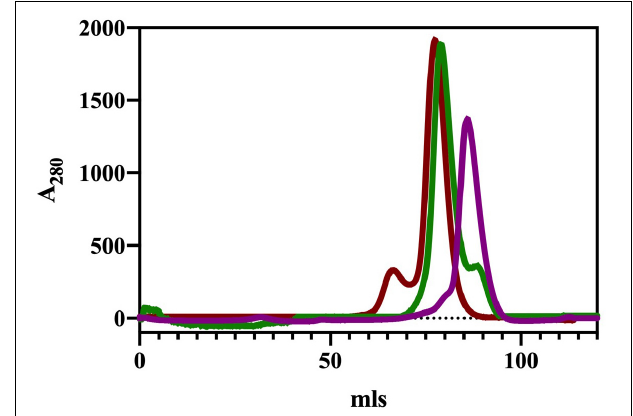
FIGURE 1 | Gel filtration chromatography elution (Superdex 200) of ChTK-C, ChTK-N and ChTK-F. ChTK-C with apparent molecular mass suggesting a tetramer ( ∼ 132 kDa) (red); ChTK-N was eluted as a dimer ( ∼ 62 kDa) (purple); and ChTK-F was eluted as a heterotetramer (green). A slight decrease in the MW can be observed between the ChTK-F and ChTK-C peak as well as a small ChTK-N peak in the ChTK-F trace corresponding to the excess ChTK-N used in the